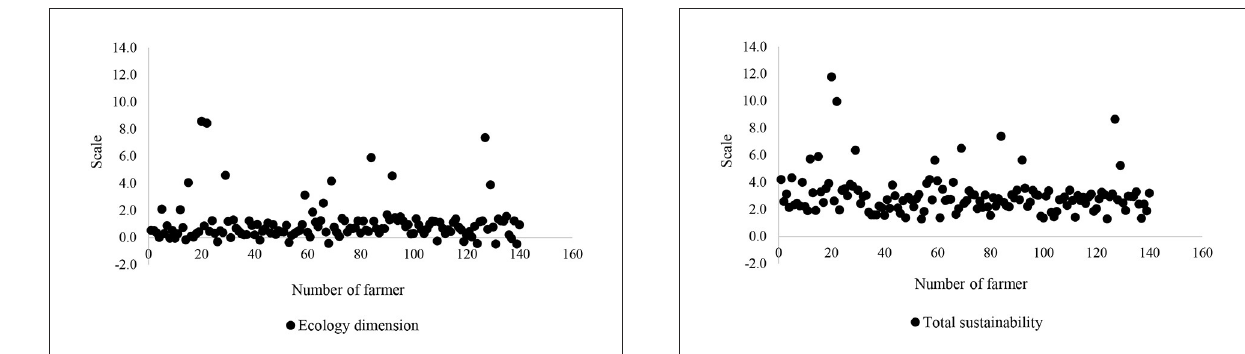
FIGURE8 Scatter of the total score of the agricultural sustainability of local